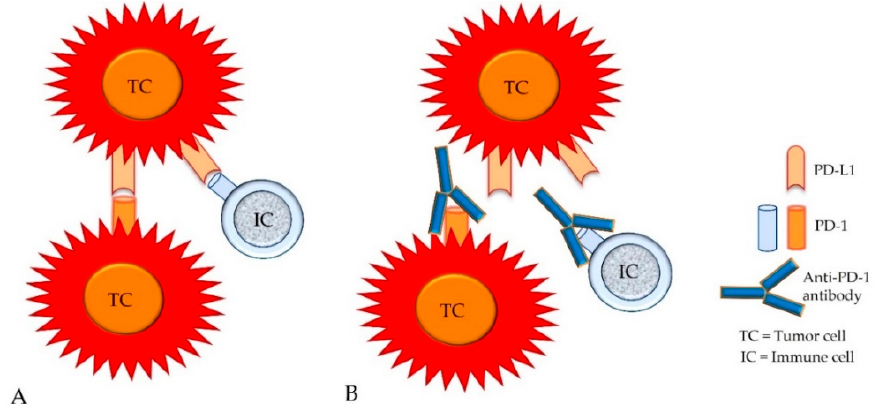
Figure 7. In addition to the expression of PD-L1, the intrinsic expression of PD-1 has been detected on variable numbers of tumor cells from different cancer types. Therefore, PD-L1 molecules of tumor cells (TCs) can bind not only to PD-1 molecules of immune cells (ICs), but also to PD-1 molecules of tumor cells ( A ). Both types of cellular interactions can be blocked by anti-PD-1 antibodies ( B ).